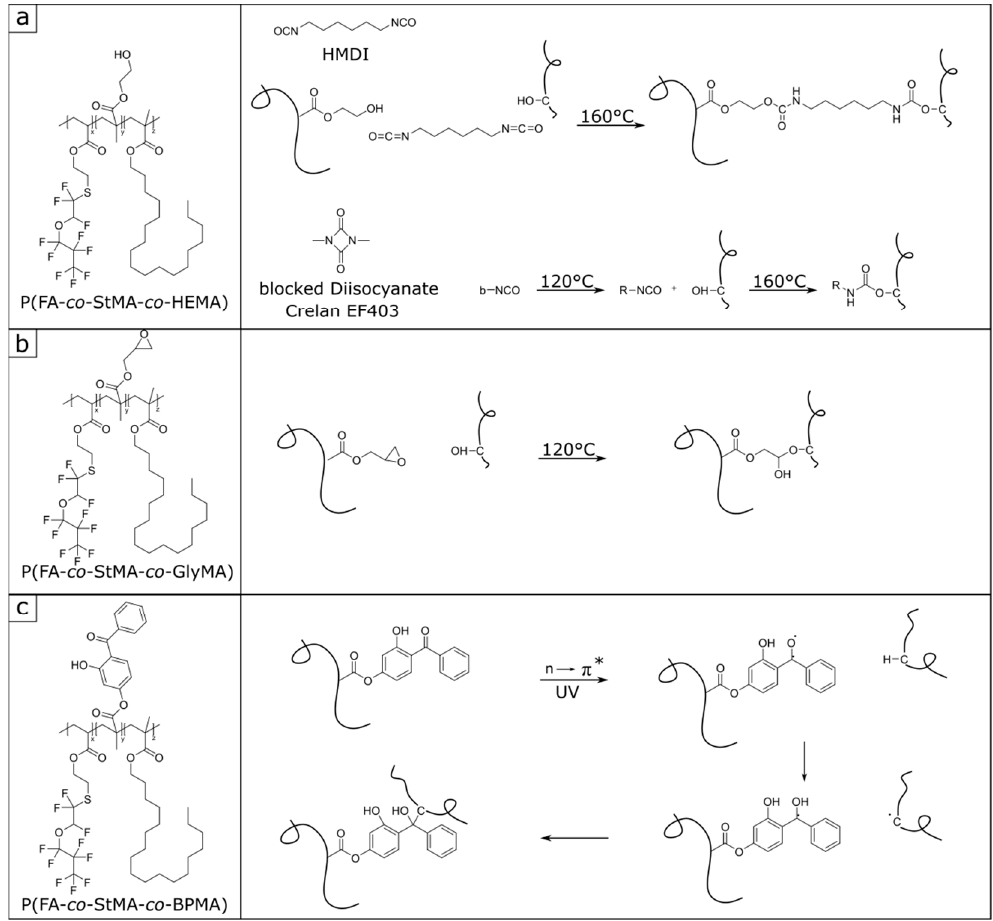
Figure 5. Scheme of the different cross-linking strategies. ( a ) Thermally induced cross-linking reaction with HEMA and two different diisocyanates HMDI and Crelan EF403, as well as the deblocking reaction of Crelan EF403, ( b ) thermally induced cross-linking reaction with GlyMA, and ( c ) UV-induced cross-linking reaction with BPMA [63].